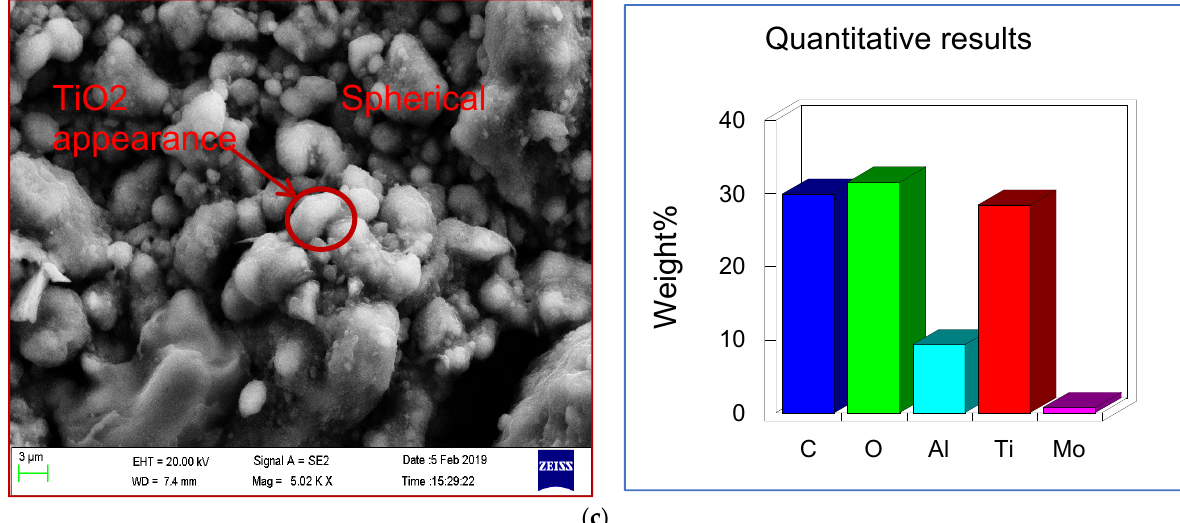
Figure 11. ( a ) Micro-structure of grinding wheel under SAE20W40. ( b ) Micro-structure of grinding wheel under veg oil. ( c ) Micro-structure of grinding wheel under veg oil + TiO 2 .